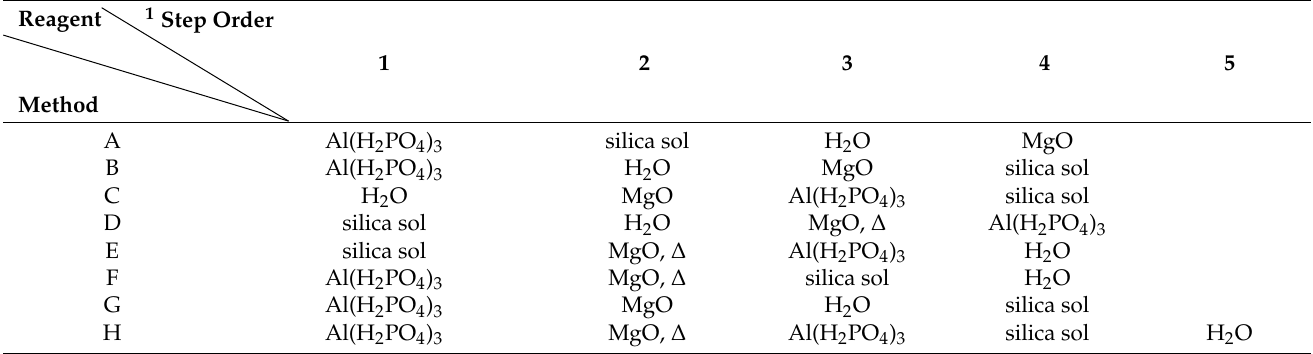
Table 6. Different methods to add MgO.